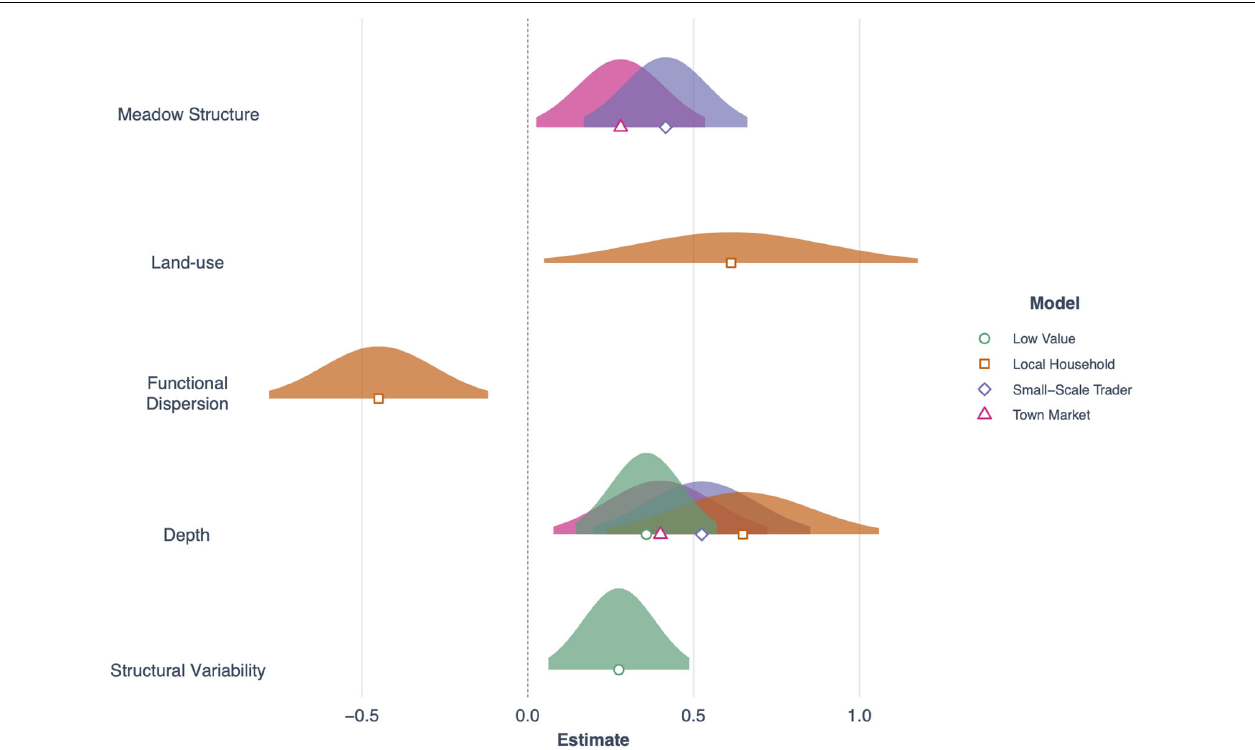
FIGURE 6 | Forest plot showing the effects of seagrass and environmental predictors across the four fish value categories used in this study (Low value, Local household, Small-scale trader and Town market). Plotted are normal distributions of 95% confidence